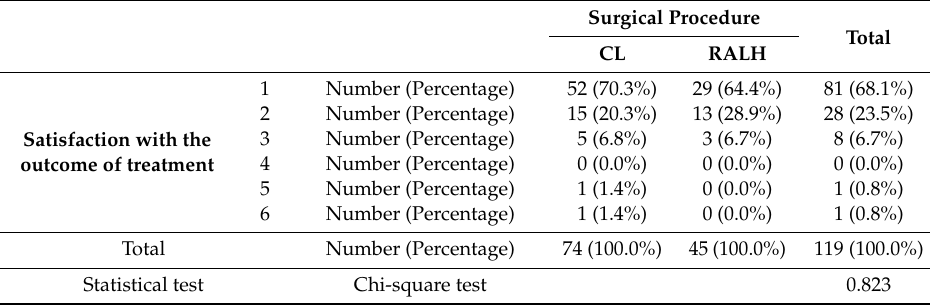
Table 4. Patient’s satisfaction-score with the outcome of the treatment based on a construct-specific satisfaction scale from 1 to 6; 1 indicated extreme satisfaction and 6 indicated